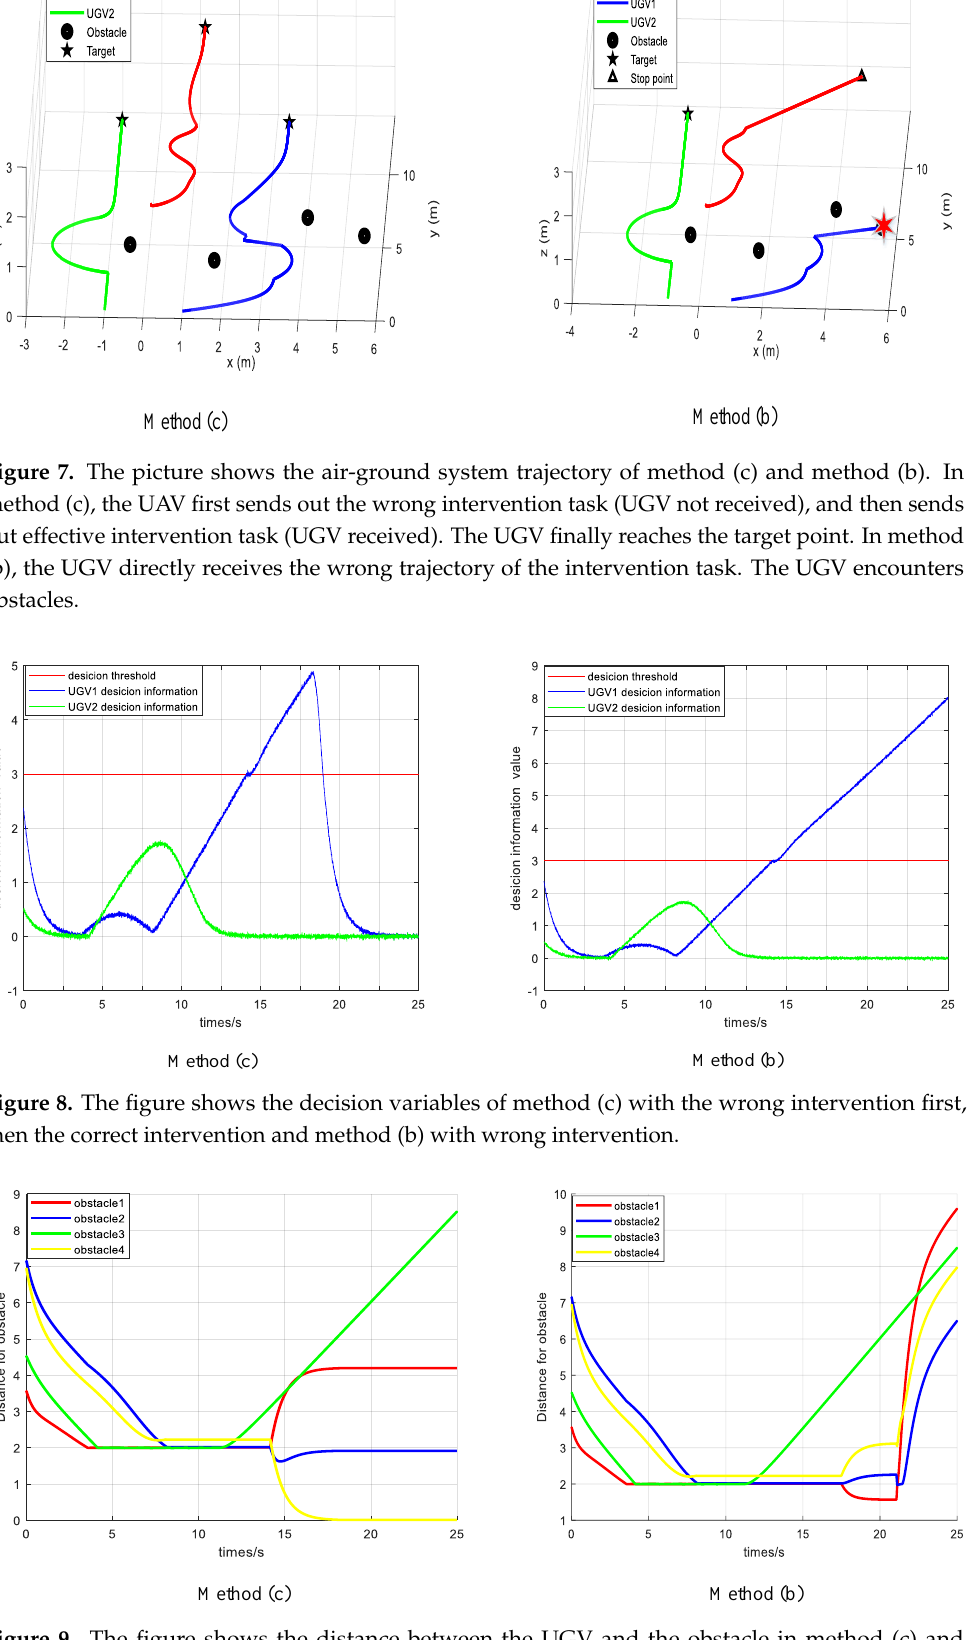
Figure 9. The figure shows the distance between the UGV and the obstacle in method (c) and method